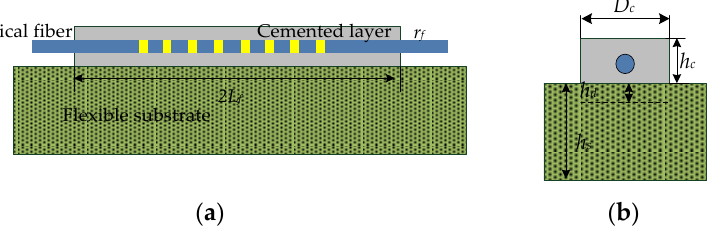
Figure 2. Schematic diagram of surface-bonded strain-transfer model: ( a ) front view; ( b ) side view. The strain-transfer model between layers is shown in Figure 3, where E , G , τ , σ , ε , and u are specified to represent the elastic modulus, shear modulus, shear stress, axial stress, strain, and displacement, respectively. The subscripts f , c , and s represent the optical fiber, cemented layer, and flexible substrate, respectively. The shear stresses between the cemented layer and optical fiber, and between the cemented layer and flexible substrate, are τ cf and τ cs , respectively. A coordinate system was established, and the element ( dx ) of each layer was taken for the force analysis.